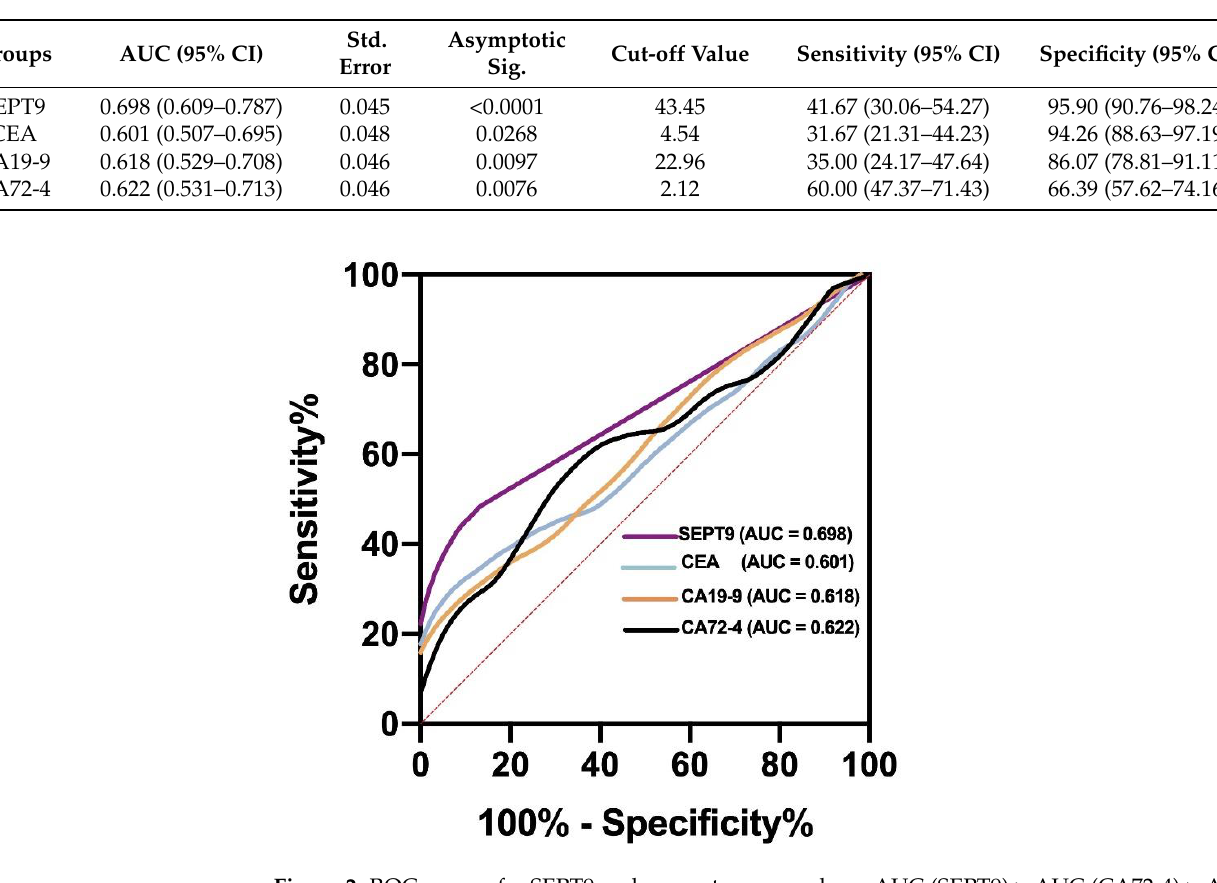
Table 3. Area under the receiver operating characteristic curve (AUC).